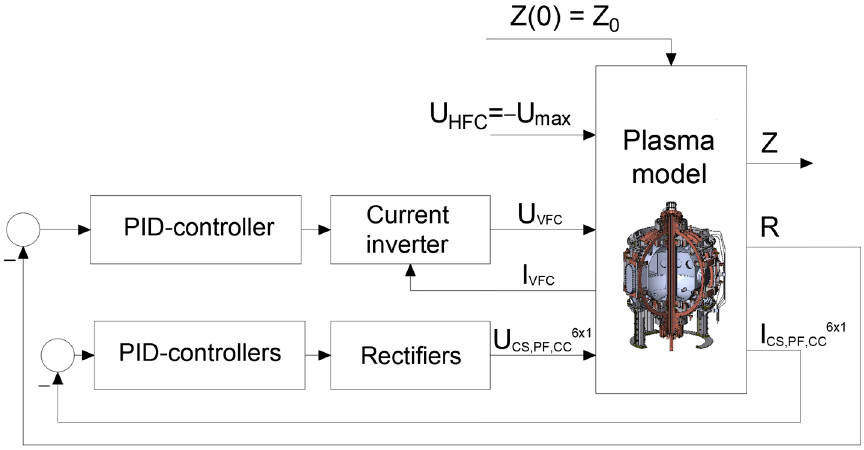
Figure 8. Block diagram of the system for the numerical estimation of the vertical plasma position controllability region.